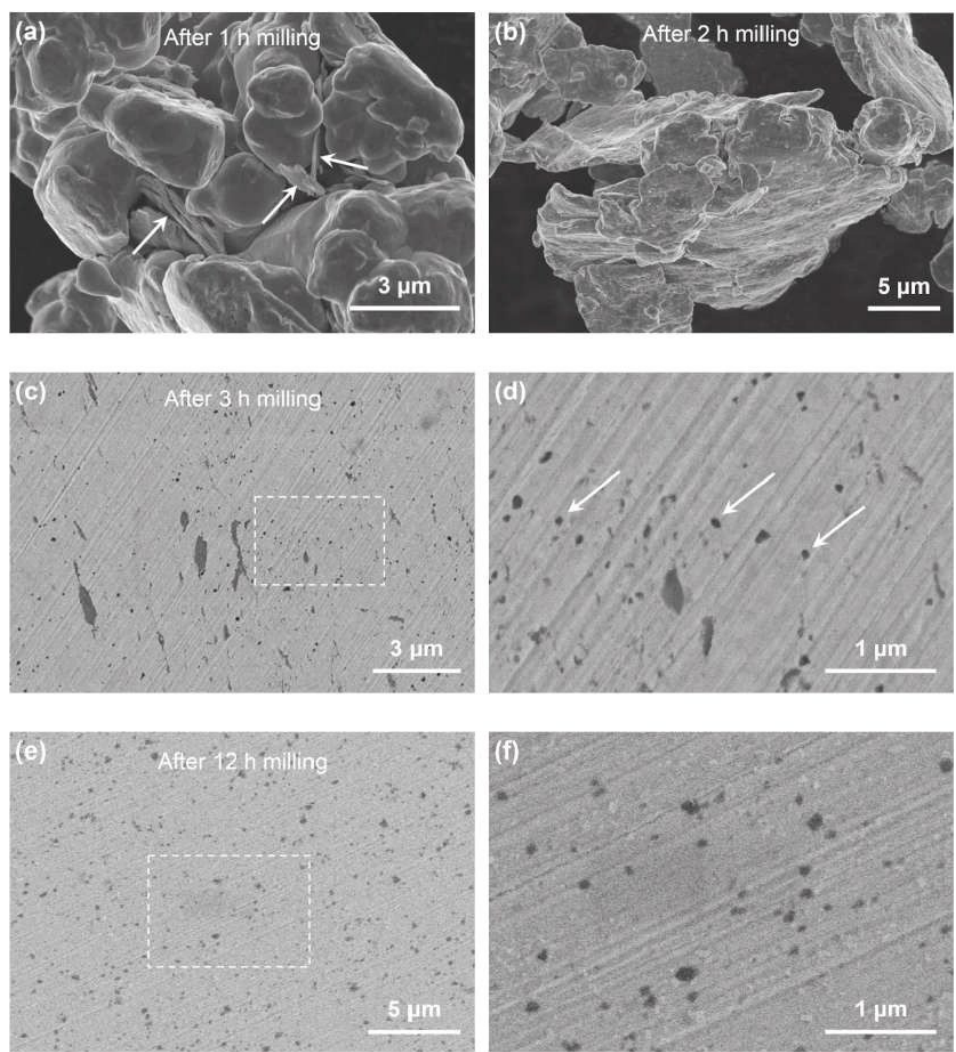
Figure 25. ( a , b ) The secondary electron SEM images of the 3MXene-Cu composite powder morphology: ( a ) 3MXene-Cu-2 h ( c – f ), the backscattered electron SEM images of the internal structure of 3MXene-Cu composite powders; ( c ) 3MXene-Cu-12 h, which were observed using the composite powders embedded in bakelite; ( d ) and ( f ) are the enlarged images of the rectangular areas marked in ( c ) and ( e ), respectively [74].